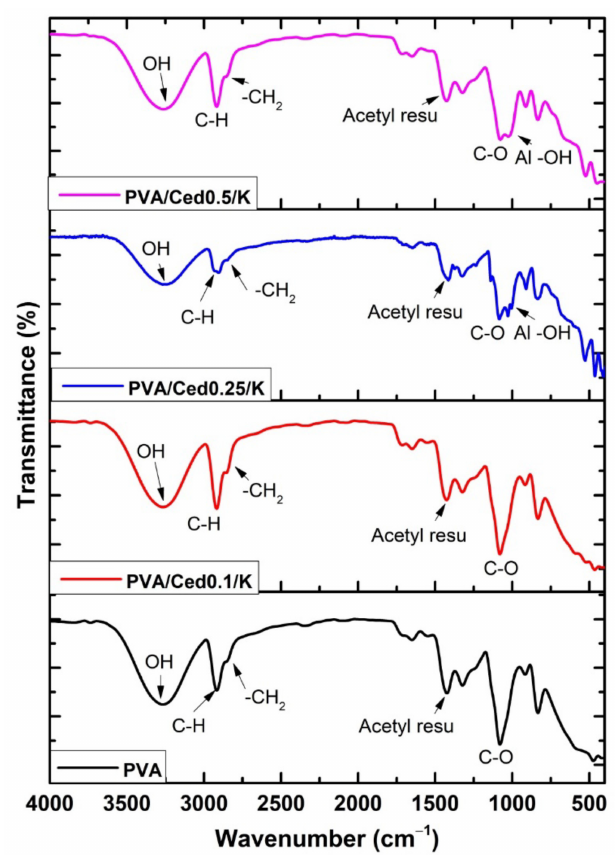
Figure 1. FTIR spectra of different PVA/Ced/K